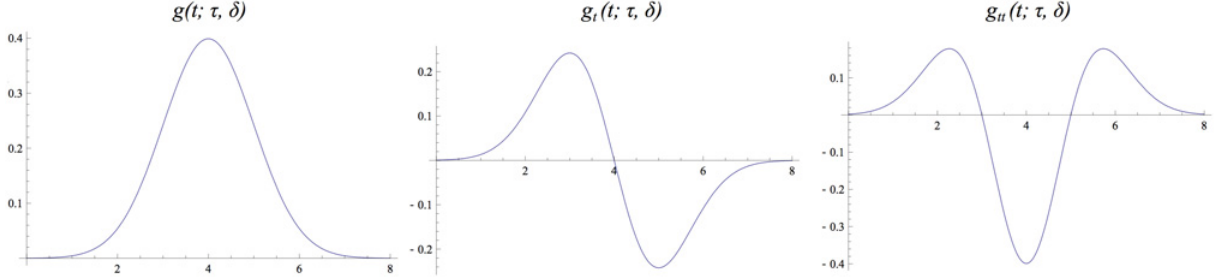
ffiffiffiffiffiffiffiffiffiffi p 2 pt